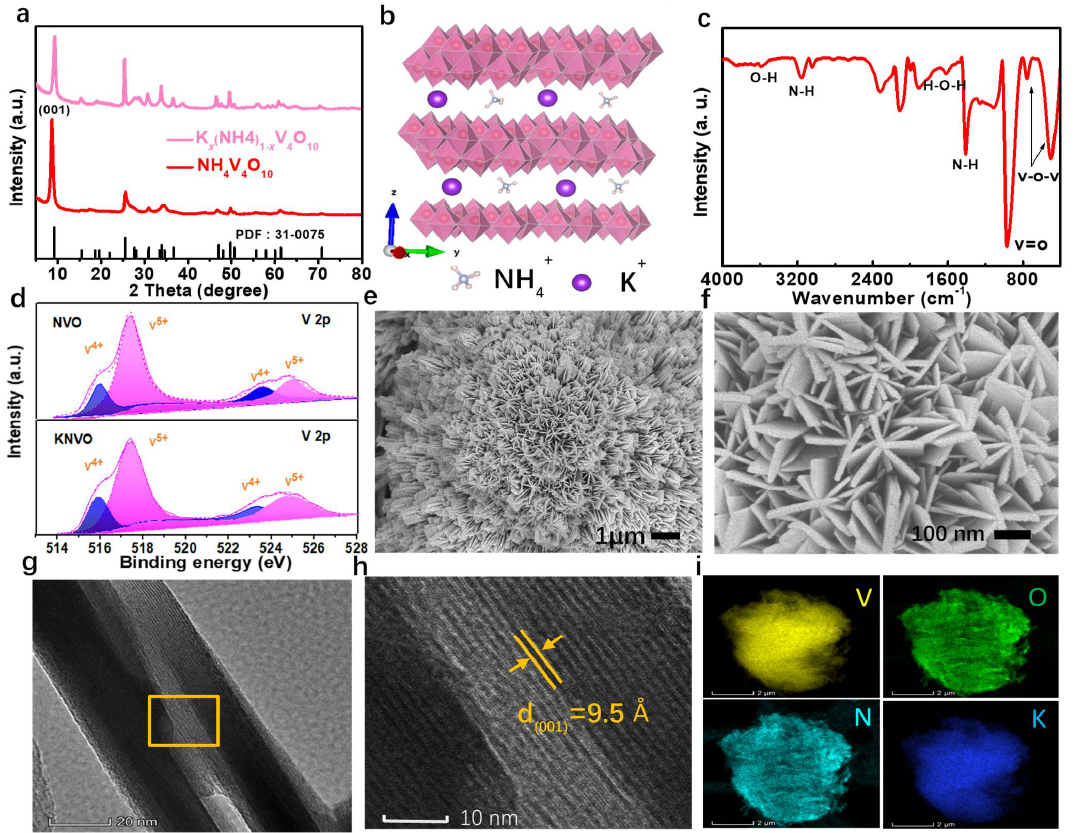
Figure 1. ( a ) XRD pattern of NVO and KNVO ( b ) Crystal structural illustration of KNH 4 V 4 O 10 . ( c ) FTIR spectra of KNVO. ( d ) V2p XPS spectrum of NVO and KNVO. ( e , f ) SEM images of KNVO. ( g – i ) TEM, HRTEM images, and elemental mapping image of KNVO, respectively .